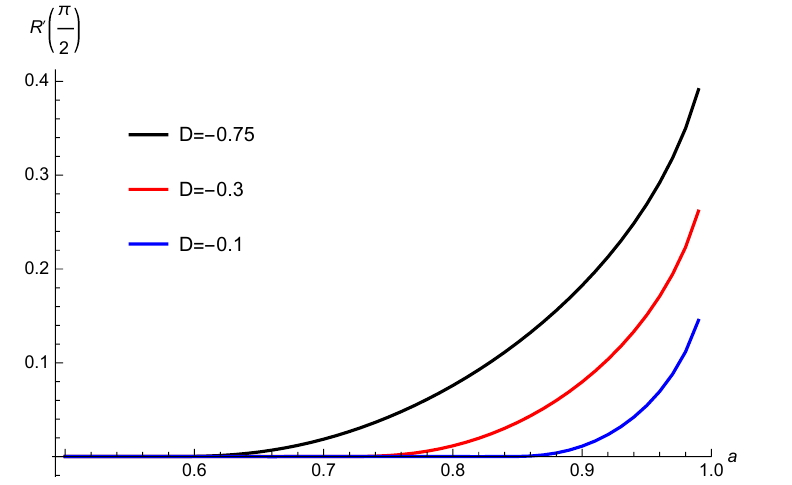
Figure 2 . Numerical value for R 0 ( π/ 2) for D = − 0 . 75 (black), D = − 0 . 3 (red) and D = − 0 . 1 (blue).